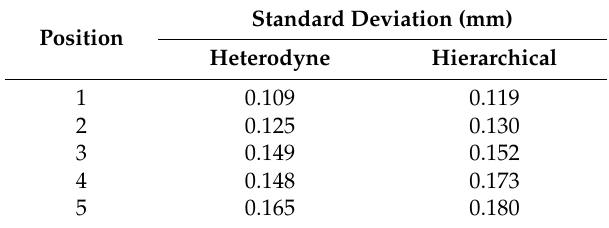
Table 1. The evaluation results of the plate